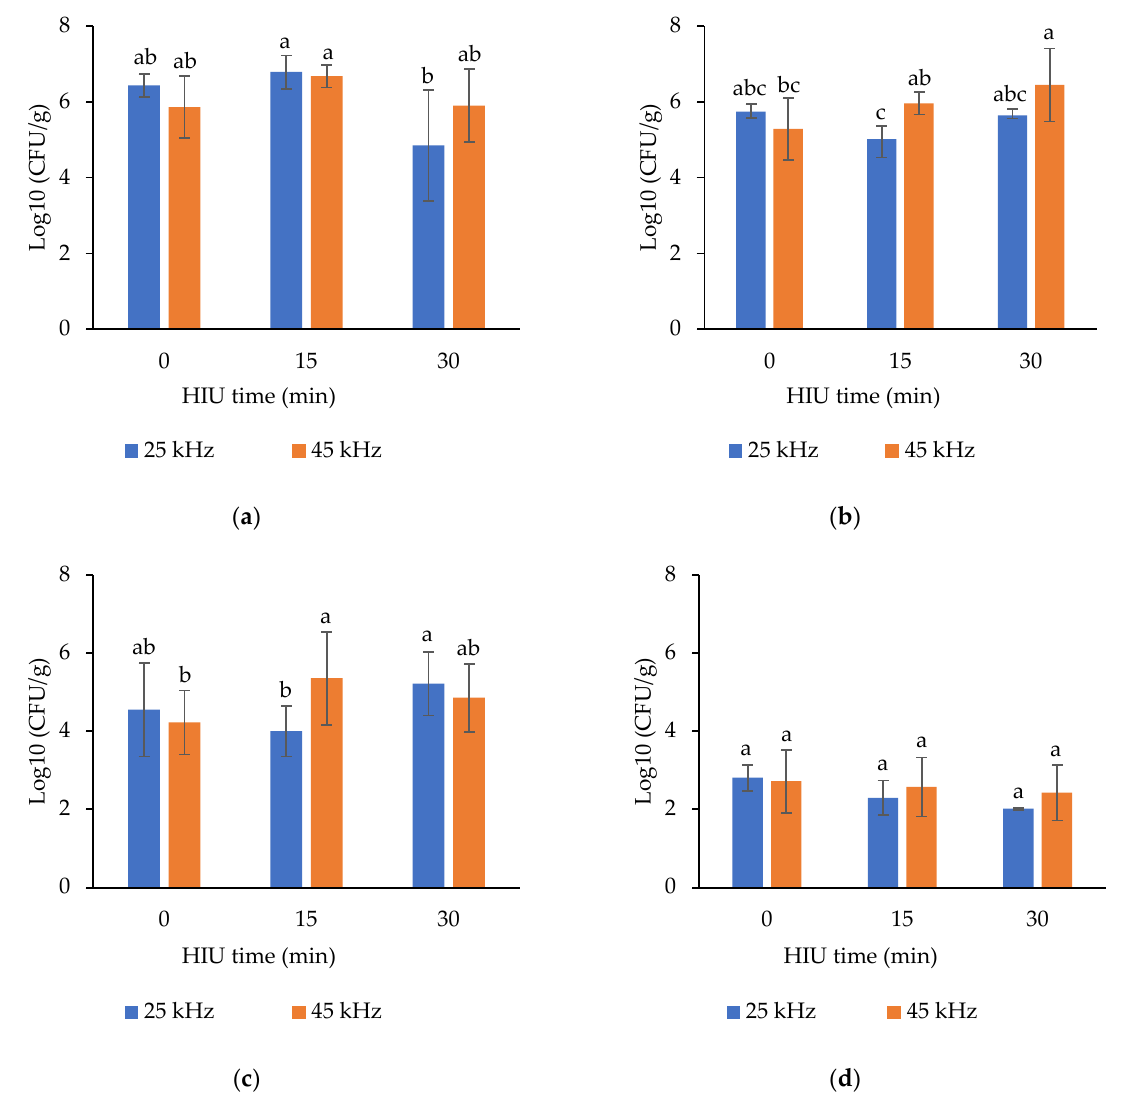
Figure 4. Effects of HIU frequency × HIU applied time to fresh raw milk on the mesophilic bacteria ( a ), psychrophilic bacteria ( b ), lactic acid bacteria ( c ), and mold and yeasts ( d ) counts of Oaxaca cheese. Data are expressed as mean ± standard deviation ( n = 3). a,b,c Different letters in the columns within the same graph indicate significant differences between treatments (Tukey´s multiple range tests assuming a significant difference at p < 0.05).